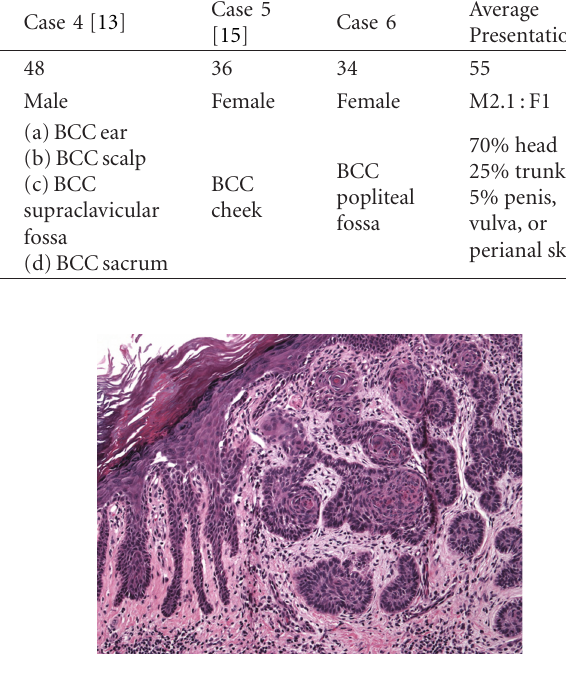
Figure 7: Histopathology demonstrating nodular basal cell car- cinoma surrounded by characteristic suprabasal acantholysis and dyskeratosis seen in Darier’s